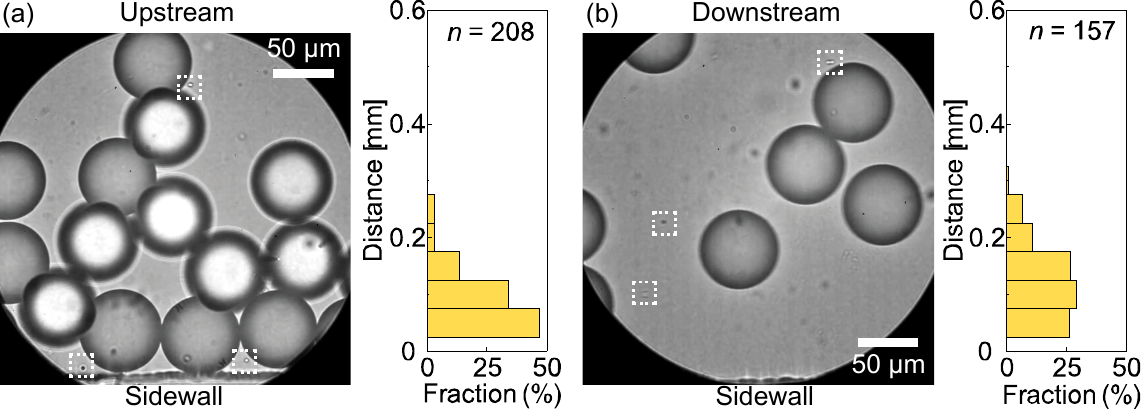
Figure 7. Satellite droplets flowing in the no-pillar device. ( a ) The satellite droplets (in the dashed white squares) flowing in the ( a ) upstream and ( b ) downstream regions and their distances from the sidewall. Flow rates were Q d = 0.1 mL/h and Q c = 10.0 mL/h.